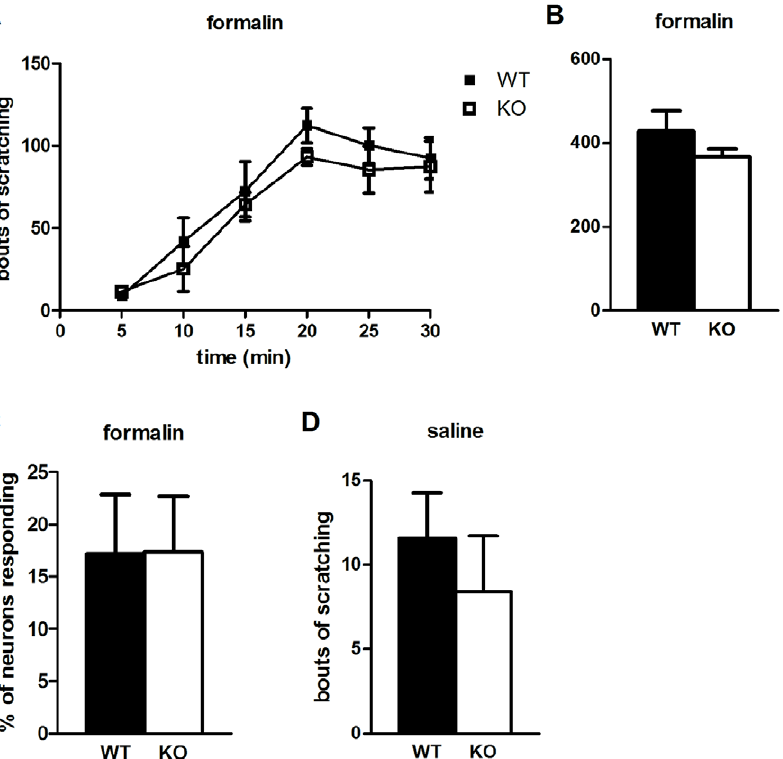
Figure 5. Pirt is not involved in all types of itch. ( A , B ) Pirt WT (n=10) and KO (n=8) mice display comparable formalin-induced (5%) itch behavior. ( C ) Ca 2 + responses to formalin (0.02%) are unaltered in Pirt mutant DRG neurons (n=6 per genotype). ( D ) Saline vehicle induces a similar baseline, i.e. spontaneous, scratching response in Pirt 2 / 2 (n=5) and WT (n=7) mice.